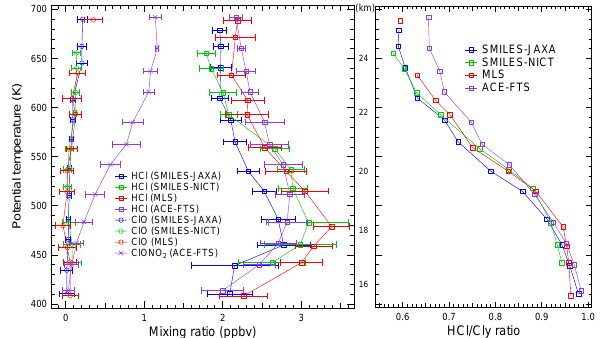
Fig. 5. Vertical profiles of ClO (measured by SMILES and MLS), ClONO 2 (measured by ACE-FTS), and HCl (measured by SMILES, MLS, and ACE-FTS) on 19–24 November 2009 inside the Antarctic vortex (within the edge center) as a function of poten- tial temperature, PT (left panel). Horizontal bars show ± 1 σ stan- dard deviations of the averages. Approximate altitudes correspond- ing to PT are shown on the right-hand side of the panel. HCl/Cl y ratios computed for each of the three instruments are shown in the right panel. For a derivation of Cl y , see Sect.